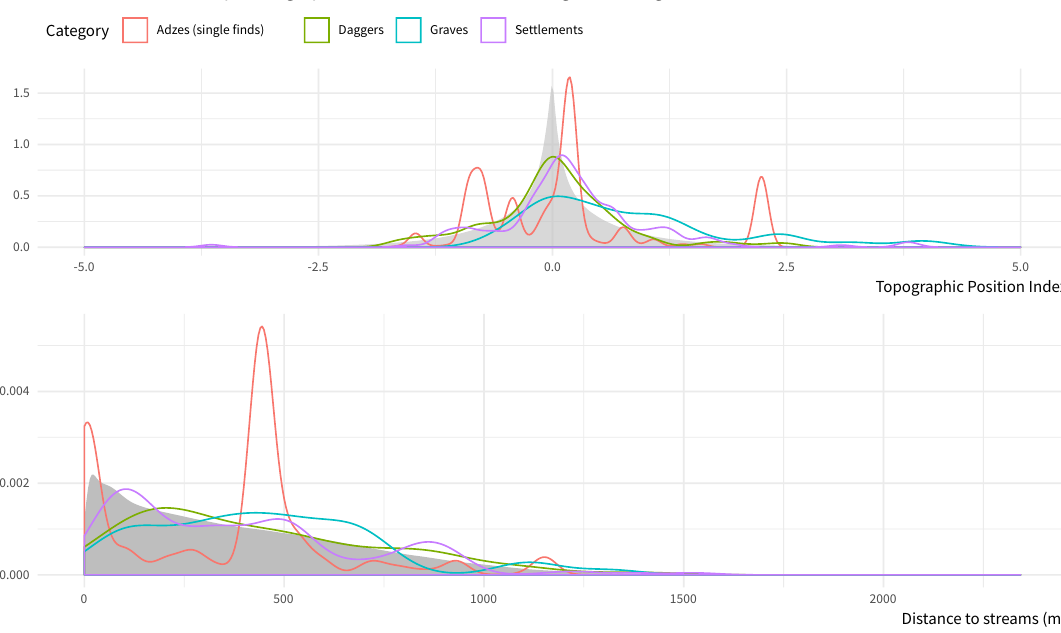
Figure 9. Relative location characteristics of the study area (gray shaded area) and the employed archaeological sites (colored lines). It becomes obvious that the characteristics of the individual types of archaeological sites differ with respect to the other types and to the study area